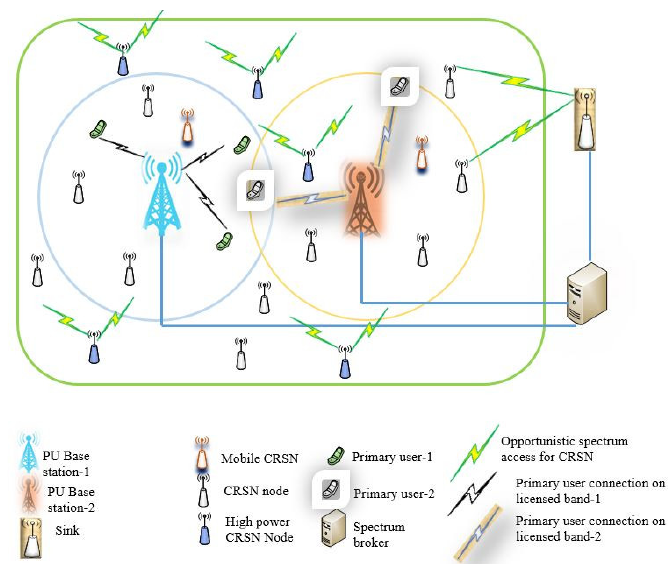
Figure 1. Typical cognitive radio sensor network (CRSN) architecture.